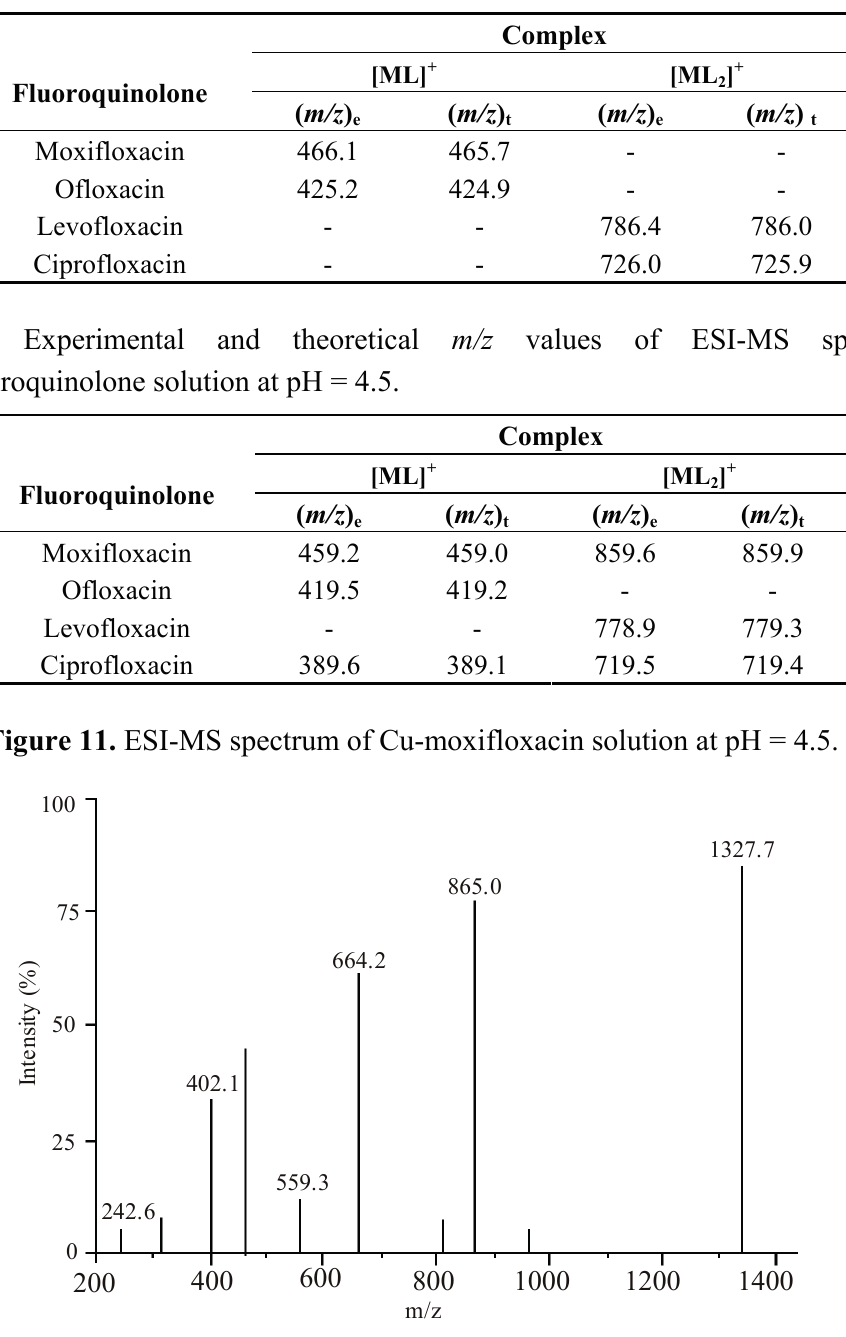
Table 7. Experimental and theoretical m/z values of ESI-MS spectra in Zinc-fluoroquinolone solution at pH = 4.5.